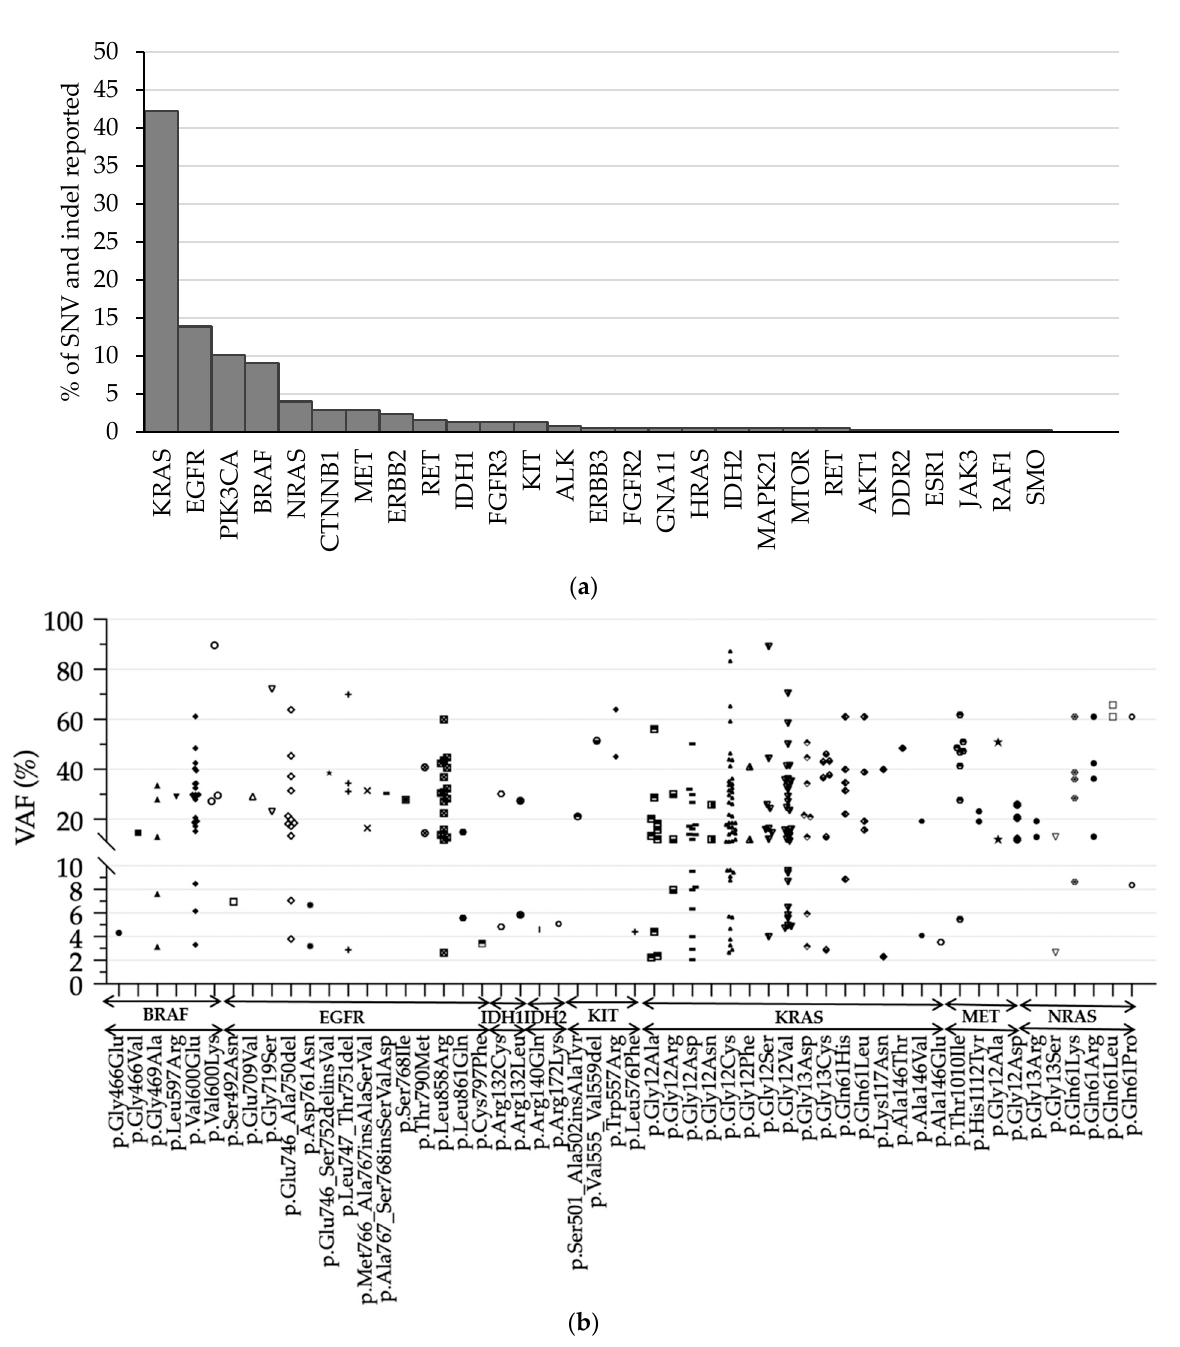
Figure 4. Reported mutations in clinical samples during 21-month follow-up. ( a ) Distribution of all mutations detected across DNA clinical samples (276 lung, 64 colon, and 34 skin tissue samples); ( b ) VAF of reported mutations in BRAF , EGFR , IDH1 , IDH2 , KIT KRAS , MET , and NRAS genes. For a given mutation, a unique symbol was used to indicate the VAF values obtained for different clinical samples.